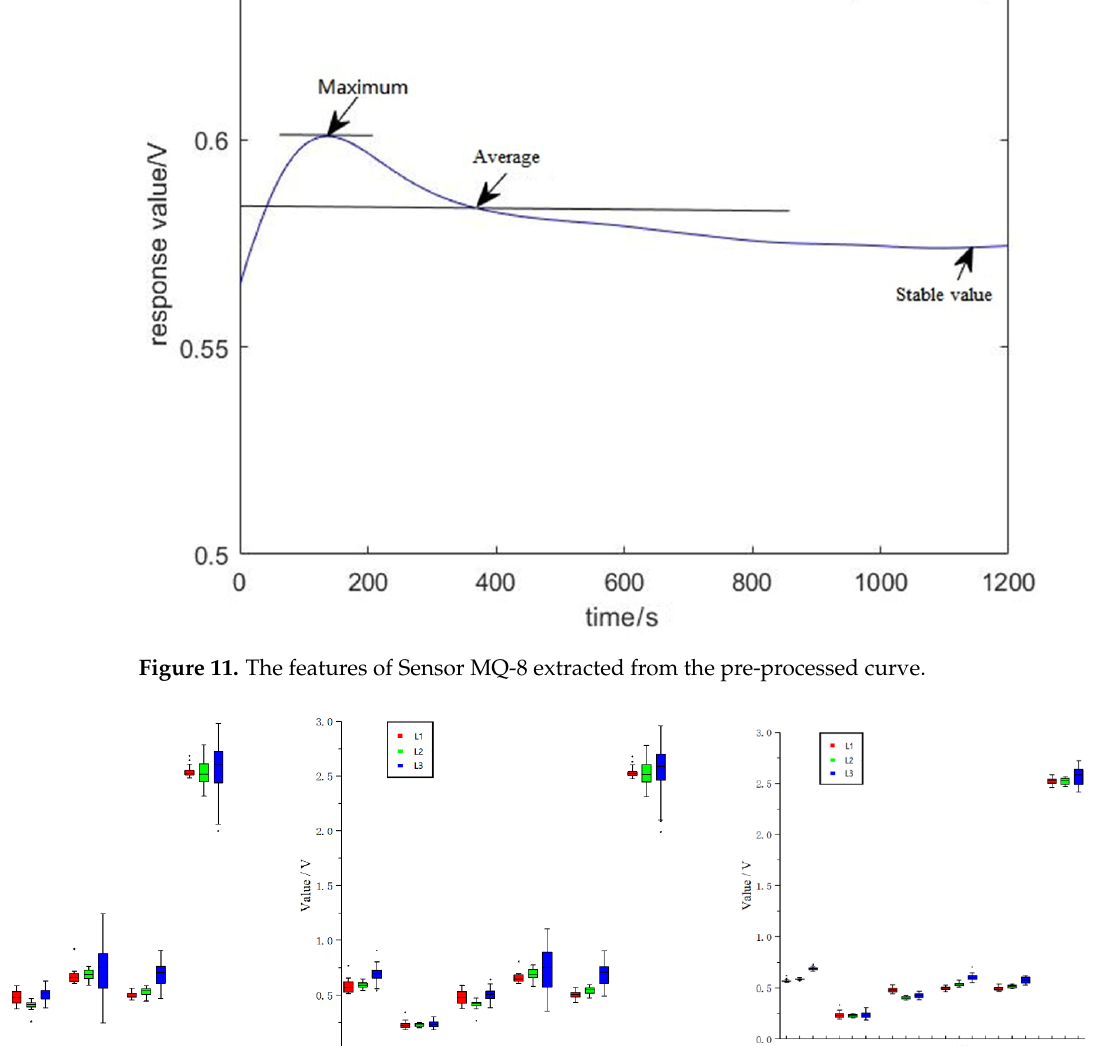
Figure 12. Boxplot showing the feature values of six sensors. ( a ) Maximum, ( b ) Average, ( c ) Stable value.